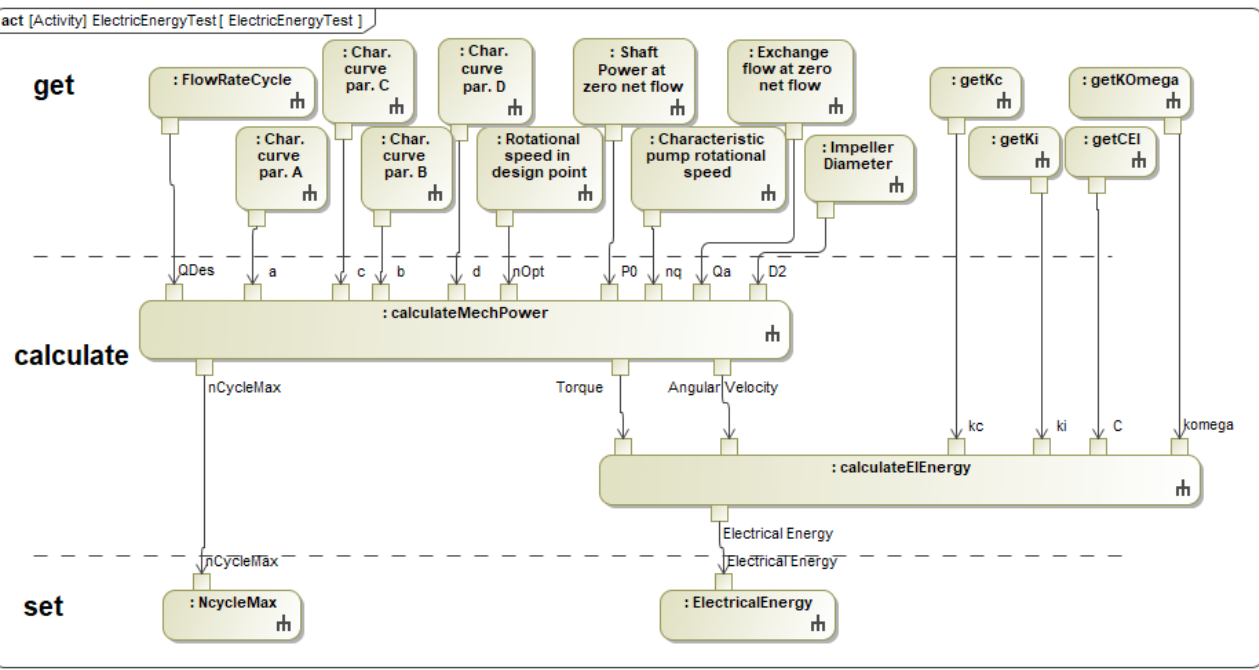
Figure 7. Test workflow for the electric coolant pump. The implementations of calculateMechPower and calculateElEnergy are described in detail in Section 3.4.